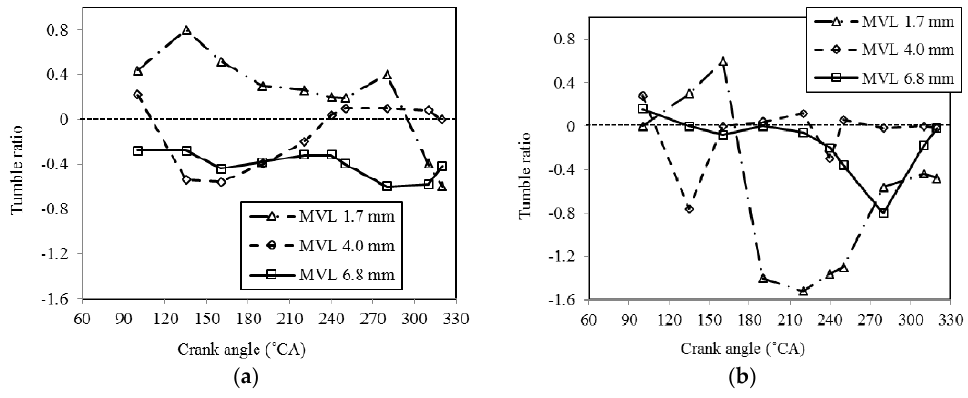
Figure 14. Tumble ratio varations as function of CA: ( a ) at Plane 1 and ( b ) at Plane 2.